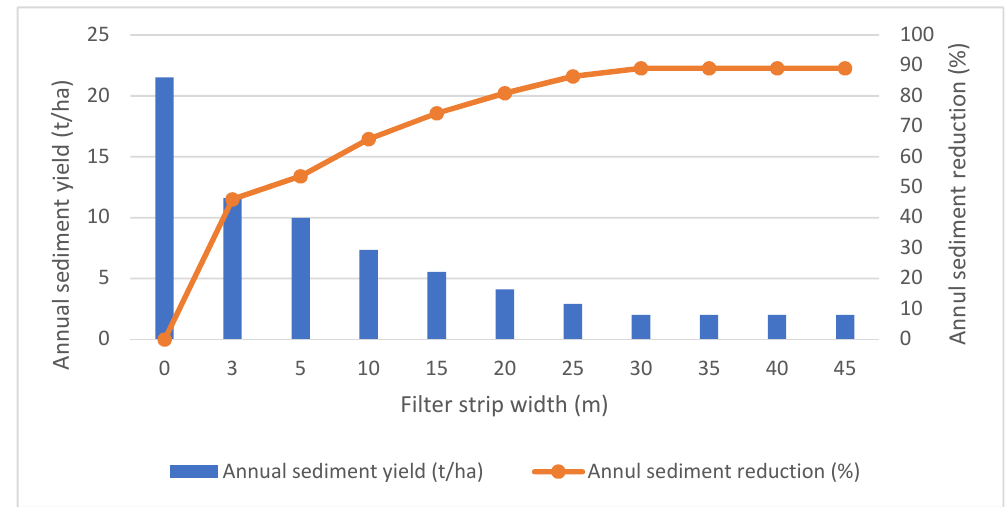
Figure 8. Simulation of annual sediment yield and sediment reduction at different filter widths.